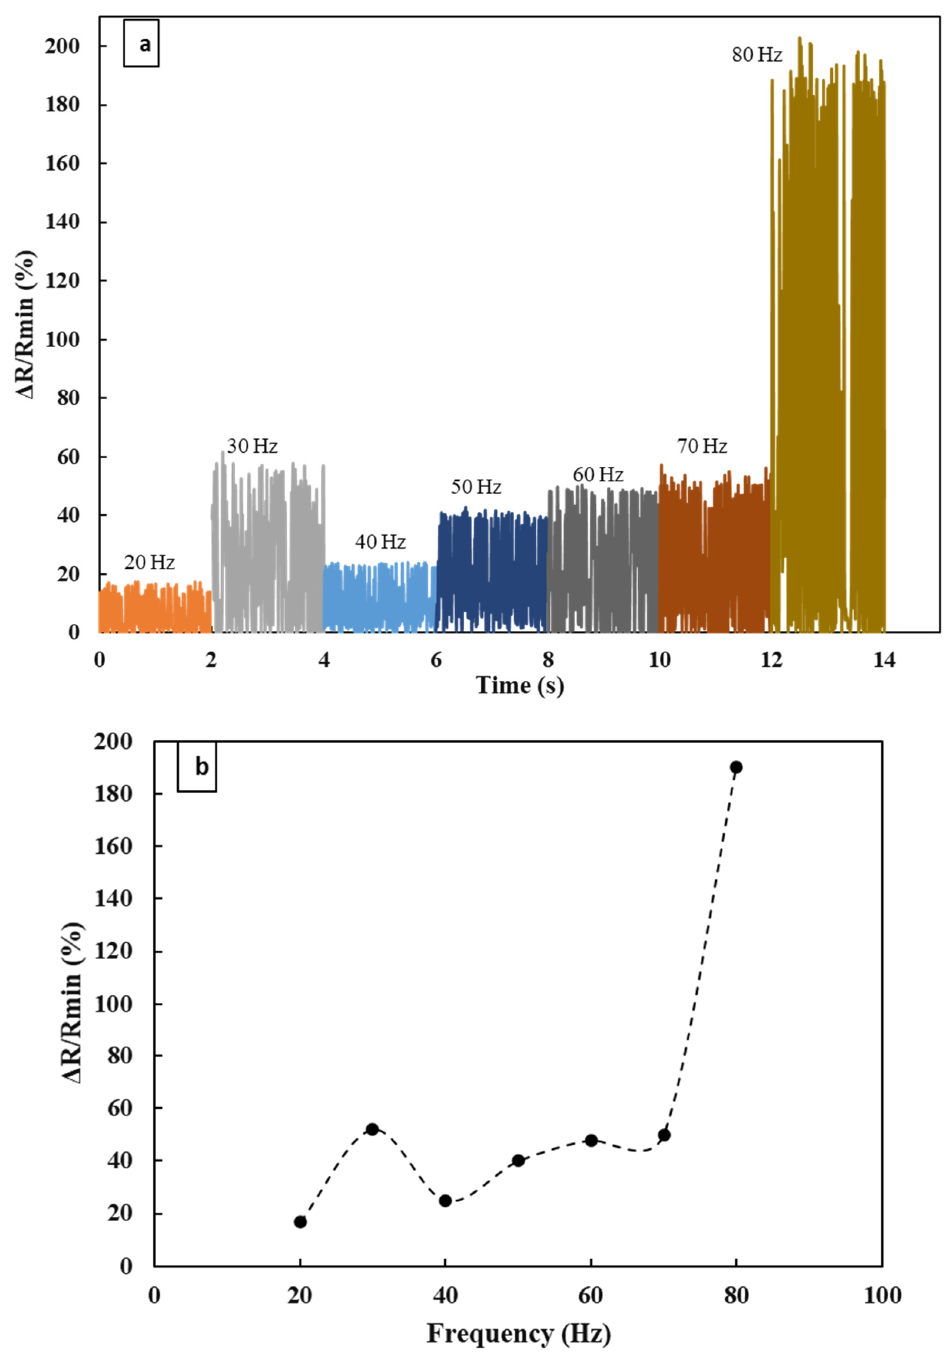
Figure 4. ( a ) Repeatability test. ( b ) Response measurement at different frequencies with a fixed amplitude of − 5 dB.